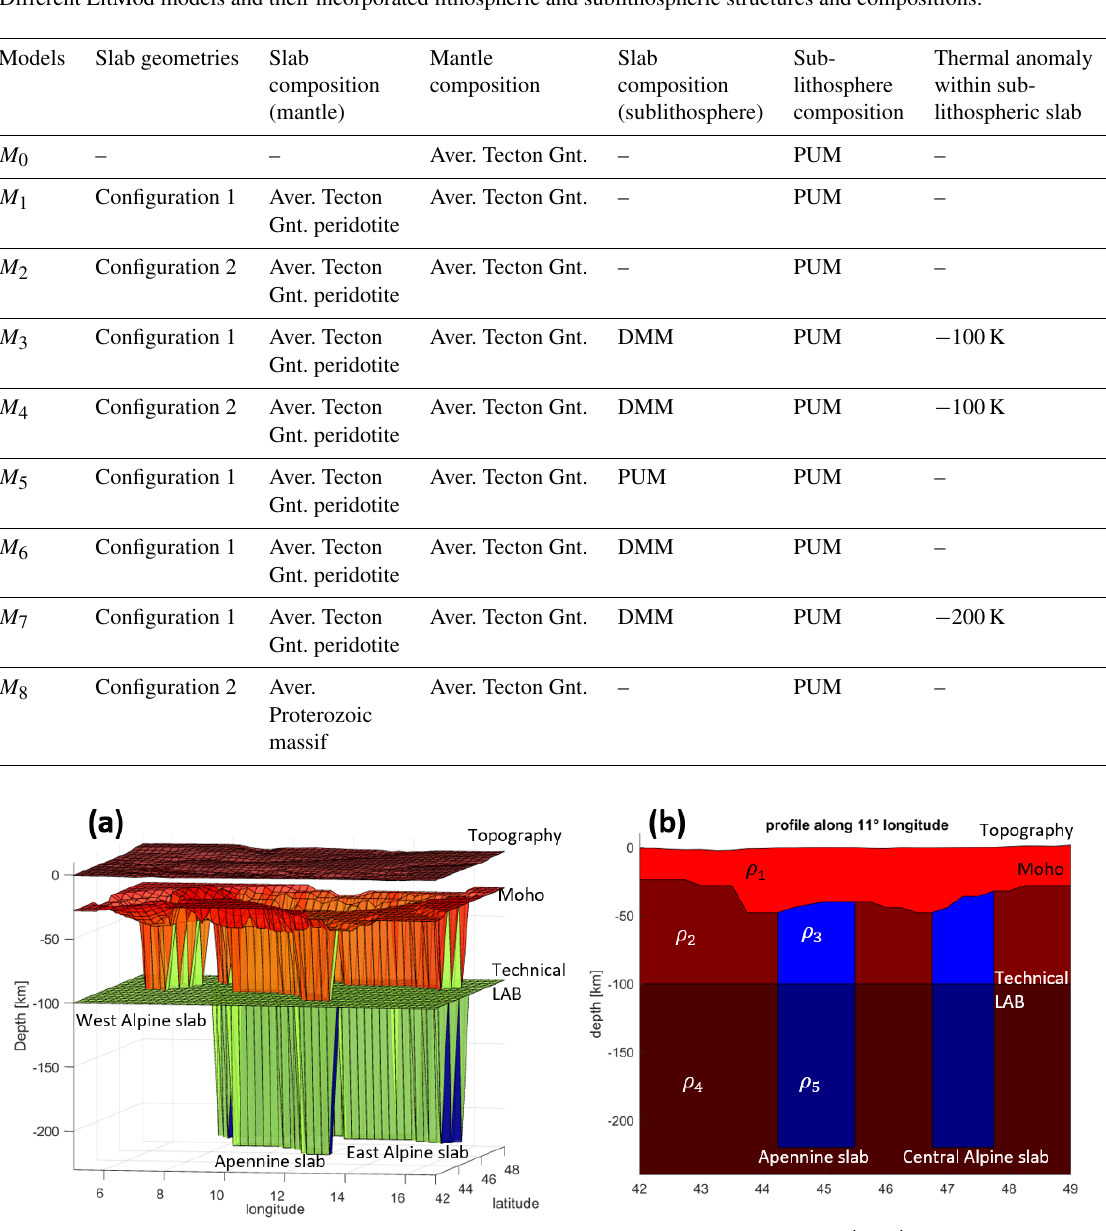
Figure 8. (a) 3-D model set up using LitMod3D. Topography, Moho and LAB depth as well as the vertical incorporated slab models are used as input layers with assigned petrophysical and thermal properties. (b) Profile along 11 ◦ longitude through a LitMod model containing topography, crustal and lithospheric thickness as well as a slab segment. ρ 1 − 5 indicate petrophysical and thermal property variations for each